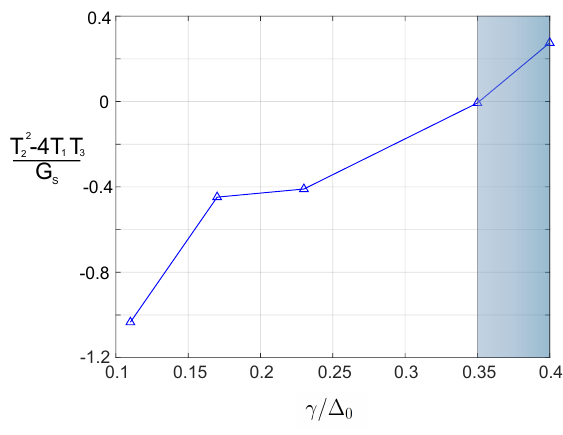
Figure 4. Normalized discriminant in Eq. (5) versus normalized deviatoric strain. The grey strip indicates the region where the discriminant changed